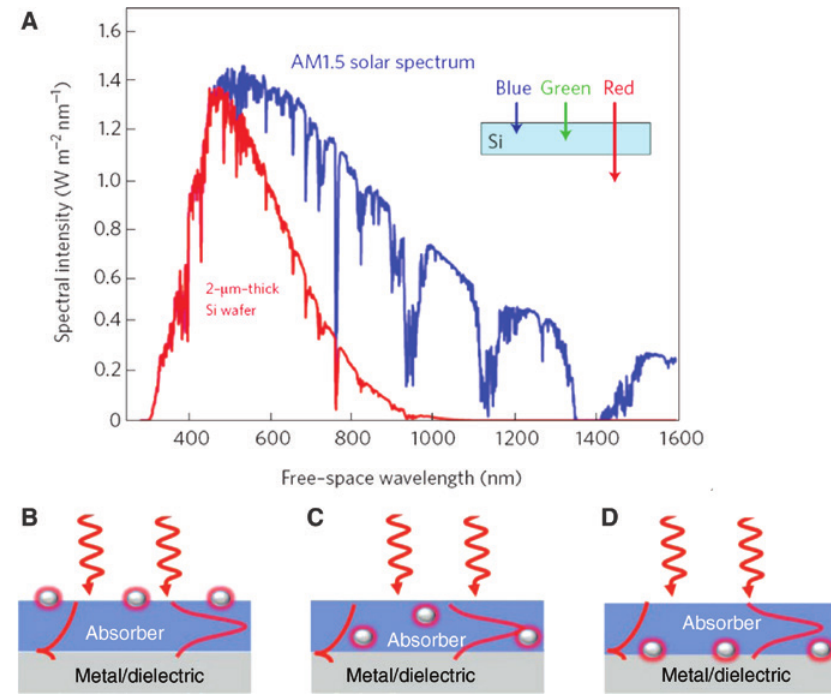
Figure 14: Schematics of the absorption AM1.5 solar spectrum and the mechanism of configurations. (A) Schematic diagram of the absorption of AM1.5 solar spectra at different thicknesses in a 2- μ m-thick crystalline silicon film [195]. Generalized scatterers for coupling into waveguide modes in a solar cell. Scatterers can consist of particles on top (B), middle (C), or back (D) of the solar cell and could contain layers of metal, dielectrics, transparent conducting oxides, or air on the back surface. Incident sun- light is then scattered into photonic or SPP modes depending on the scattering object and incident wavelength of light